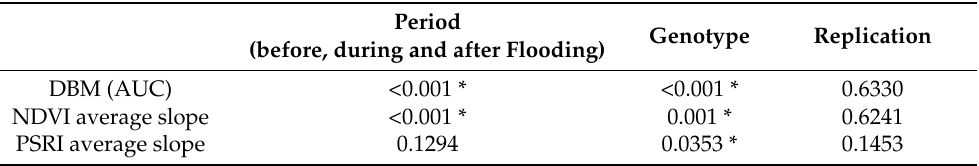
Table 1. Analysis of variance of growth and health related data measured by automatic phenotyping. Period